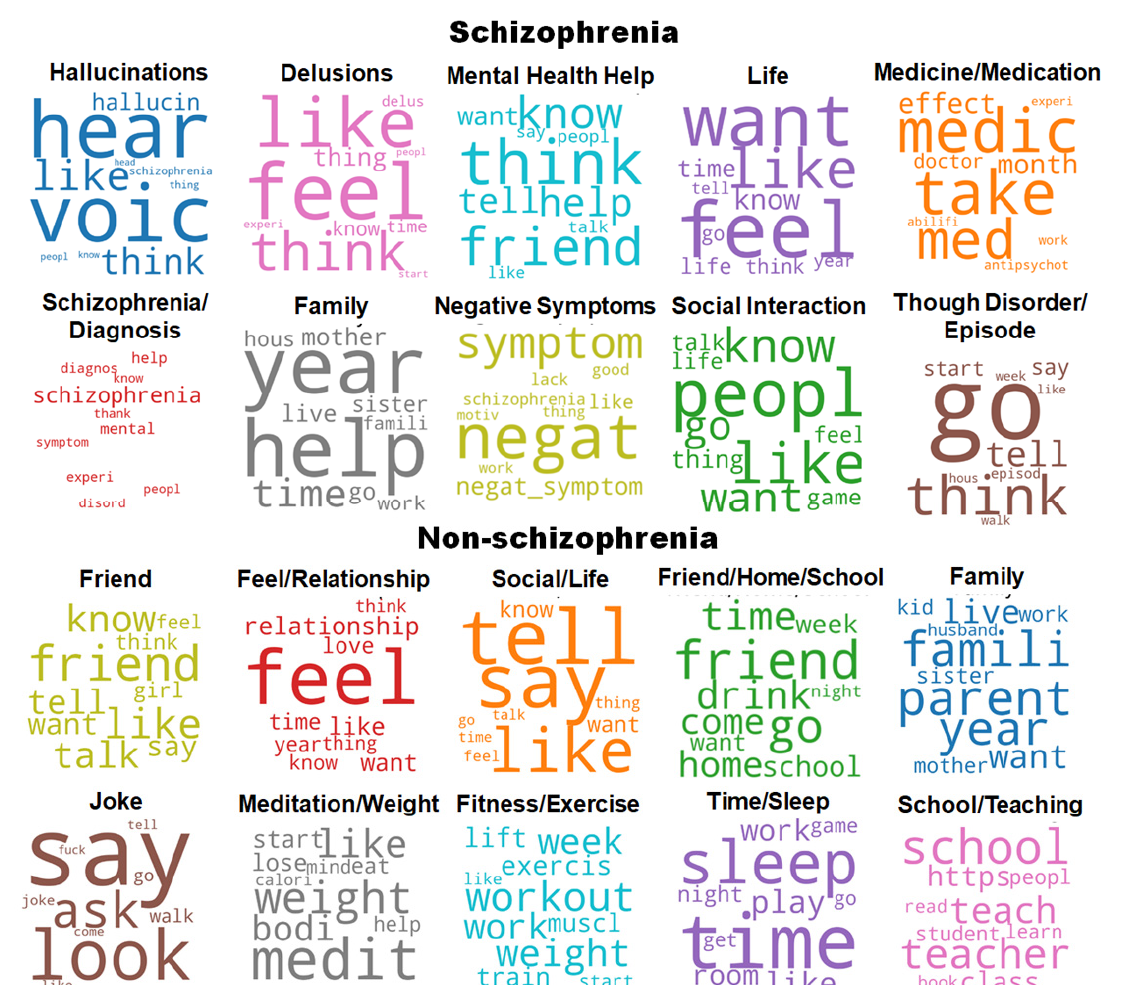
Figure 2. Word cloud visualization based on the distribution of words for each topic discovered from the schizophrenia and non-schizophrenia (control) groups.